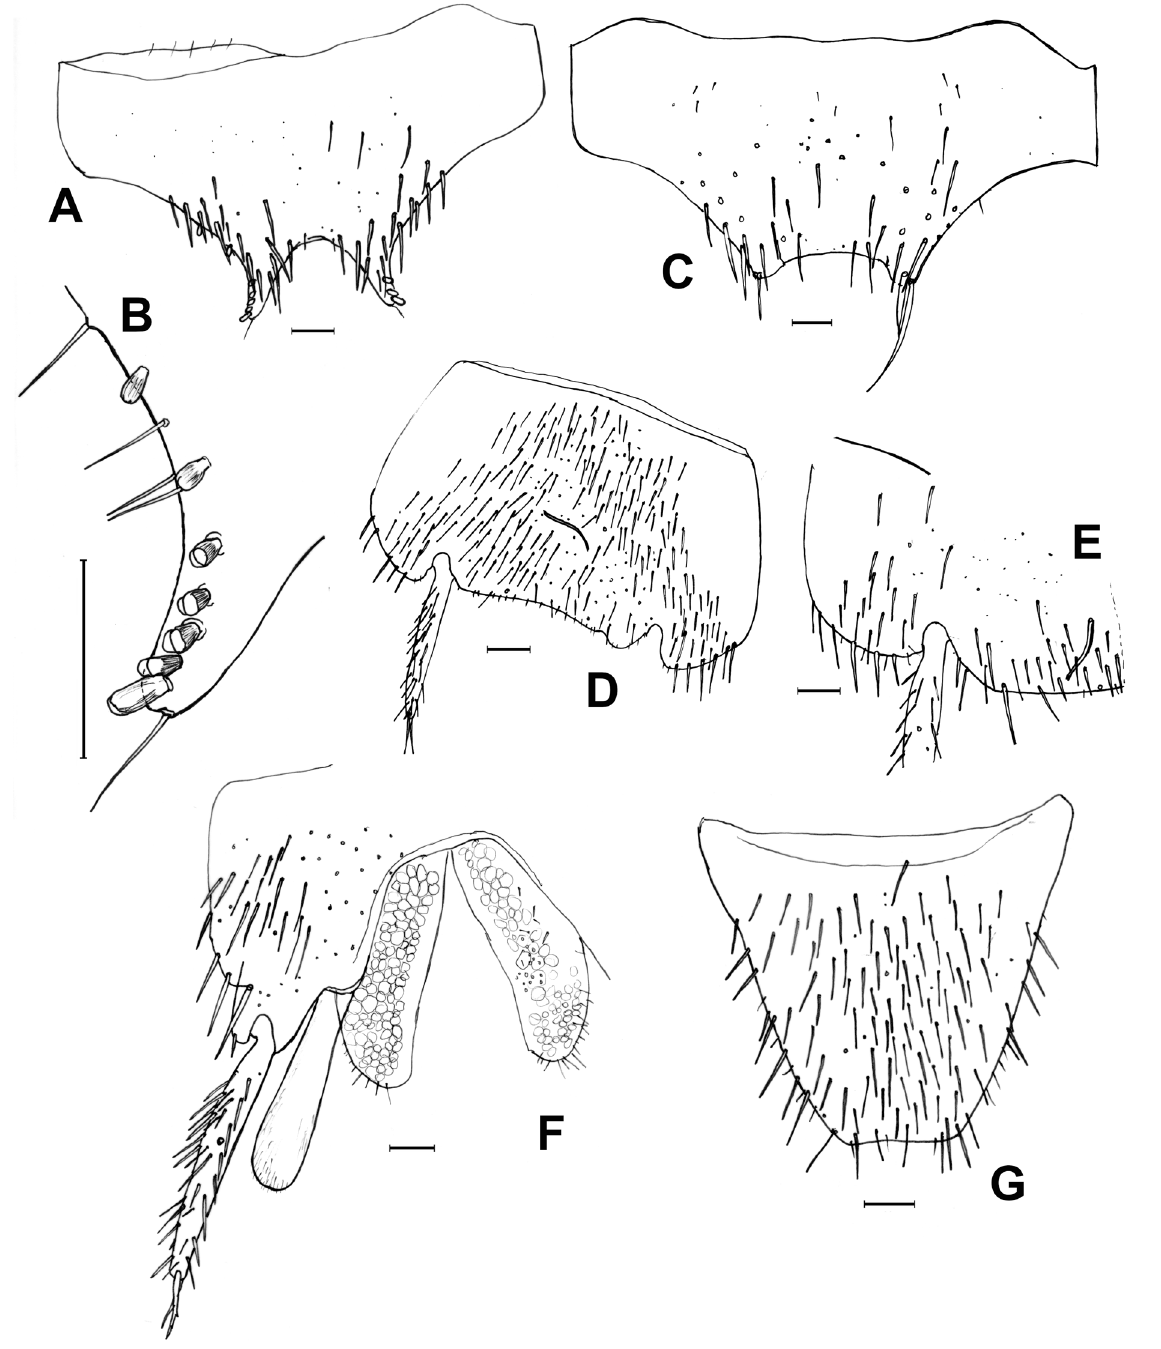
Fig. 4. Coletinia dalmatica Molero-Baltanás, Fišer, Bach de Roca & Gaju-Ricart sp. nov. A – B, E – F . Holotype, ♂ (MNCN_Ent 283558). C – D, G . Paratype, ♀ (MNCN_Ent 283559). A . Urotergite X. B . Detail of the posterolateral lobe of the urotergite X, showing pegs. C . Urotergite X. D . Urosternite VII. E . Hind margin of the right half of the urosternite VIII. F . Coxite and styli IX, paramere and penis. G . Subgenital plate. Scale bars = 0.1